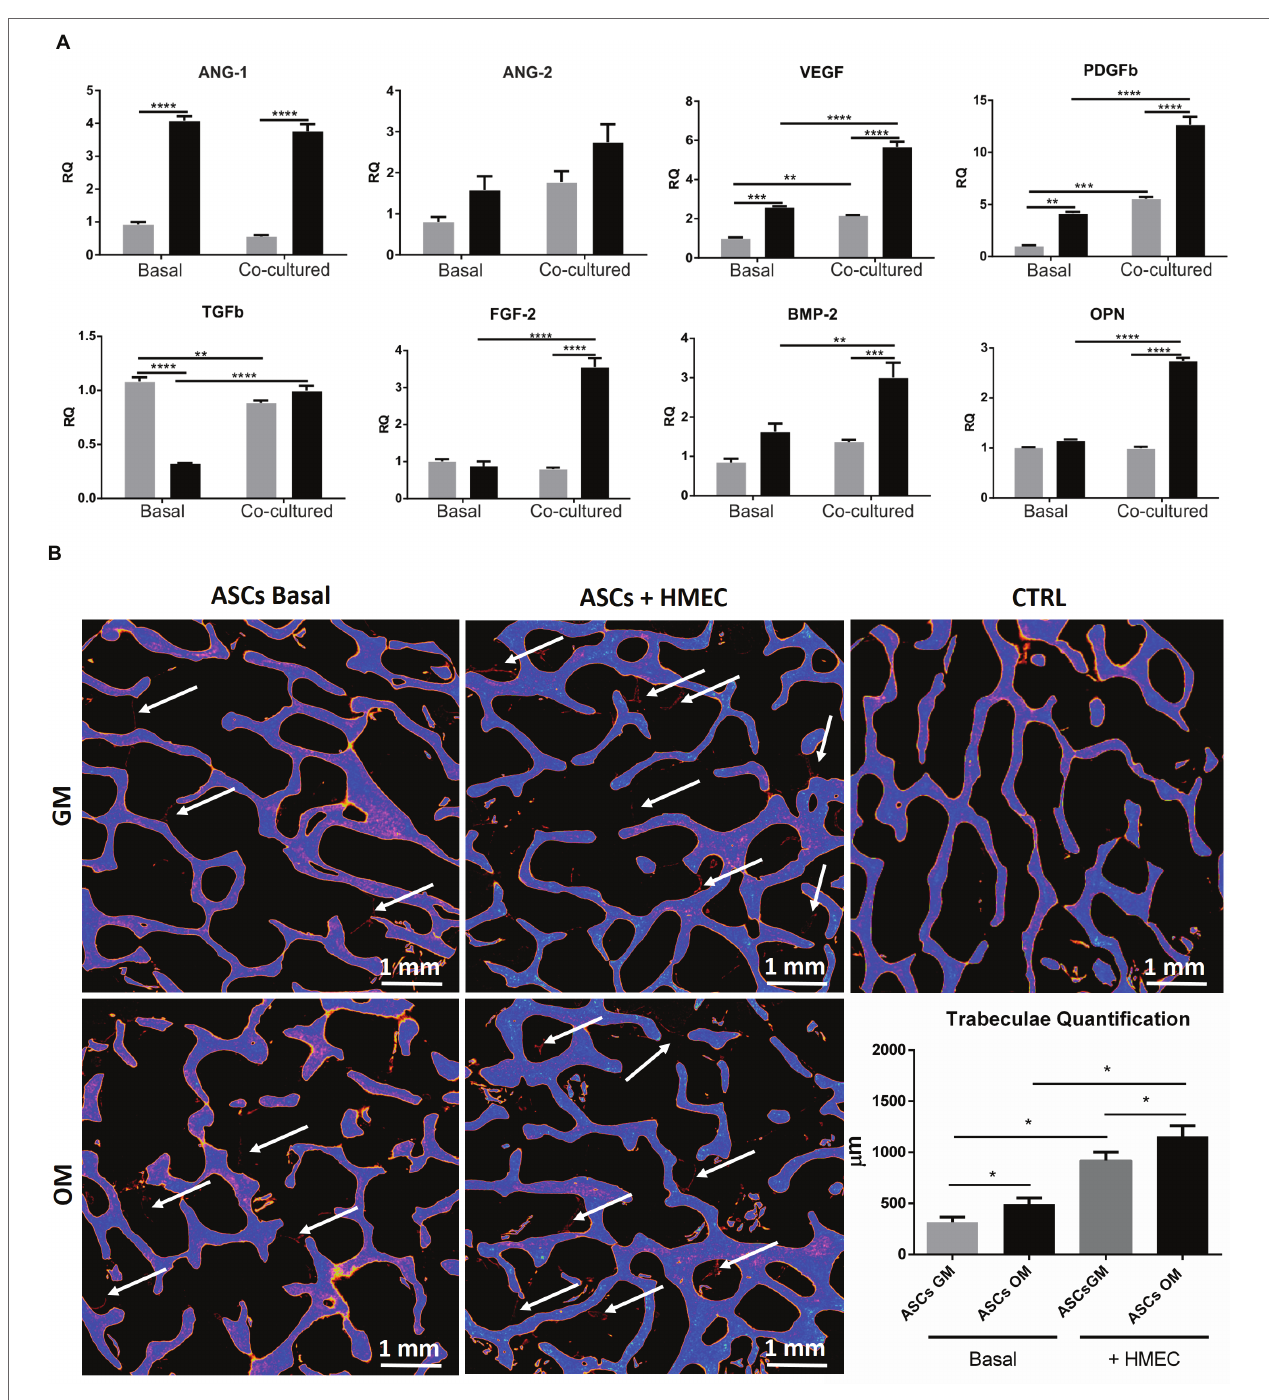
FIGURE 4 | (A) Expression profile of growth and angiogenic factors in co-cultured ASCs and HMECs. qRT-PCR analysis of growth and angiogenic factors performed on ASCs under basal conditions (without endothelial cells) or after 4 h of co-culture with HMECs. Undifferentiated (gray bar) and osteodifferentiating (black bar) ASCs are shown. Data represent mean ± SEM; n = 3. * p < 0.05; ** < 0.01; *** p < 0.001; **** p < 0.0001. Statistical analysis: ordinary two-way ANOVA with Sidak’s multiple comparisons test for grouped analyses. Ang1, Angiopoietin 1; Ang2, Angiopoietin 2; VEGF, vascular endothelial growth factor; PDGF-b, platelet-derived growth factor b; TGF-b, transforming growth factor b; FGF-2, basic fibroblast growth factor; BMP-2, bone morphogenetic protein 2; OPN, osteopontin. (B) Evaluation of bone formation by X-ray microtomography. Representative images of X-ray microtomography of bone scaffolds. ASCs were seeded in the bone scaffold and maintained in osteodifferentiating medium for 30 days. The experiment was performed in the presence (ASCs + HMEC) or not (ASCs basal) of endothelial cells. The bone scaffold is shown in blue, whereas the newly formed mineralized tissue is in red (indicated by white arrows). Quantification of the newly formed mineralized tissue for each experimental condition is reported in the histogram. ∗ p < 0 05. CTRL, bone scaffold alone; ASCs GM (gray bar) cultured for 7 days in growth medium before being seeded in the bone scaffold; ASCs OM (black bar) cultured for 7 days in osteodifferentiating medium before being seeded in the bone